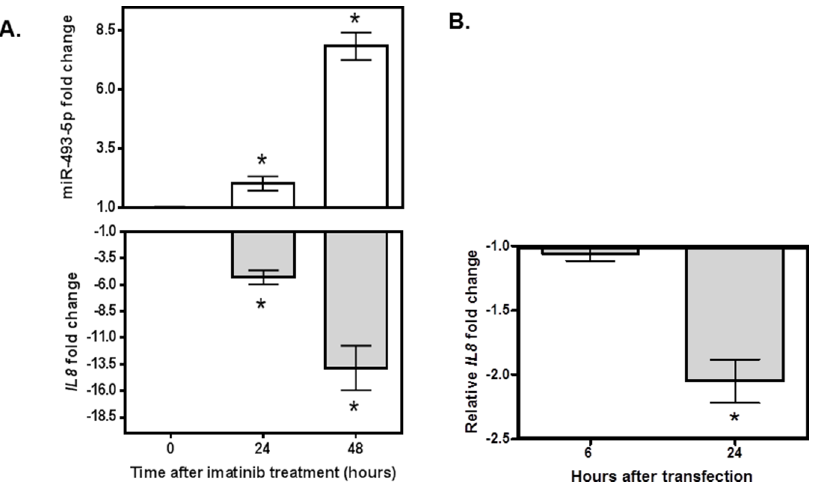
Fig. 2. Relationships among imatinib treatment, and the expression of miR-493-5p and IL8 in K562 cells. ( A ) Imatinib treatment (1 m M for 24 and 48 hours) significantly up-regulated miR-493-5p expression and significantly down-regulated IL8 expression in K562 cells (*p , 0.05, N 5 6). ( B ) IL8 is significantly down- regulated by miR-493-5p mimic at 24 hours after transfection (*p 5 0.002, N 5 6). Relative fold change was calculated by first normalizing IL8 to B2M and miR-493-5p to RNU6 and then comparing 6 and 24 hours data to 0 hour